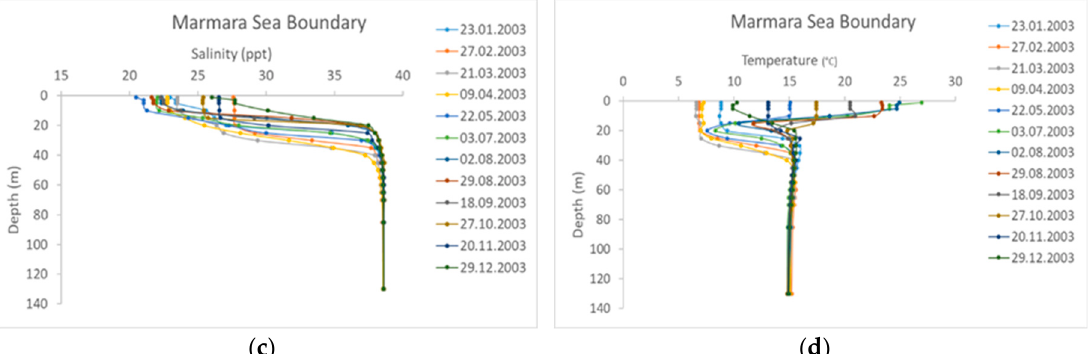
Figure 4. The first row shows ( a ) the salinity and ( b ) temperature of the Black Sea boundaries of the Istanbul Strait; and the second row shows ( c ) the salinity and ( d ) temperature of the Marmara Sea boundaries of the Istanbul Strait.